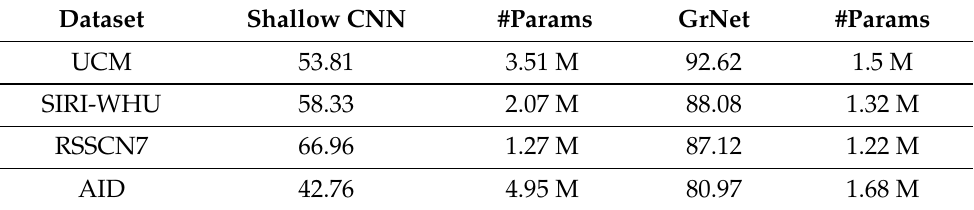
Table 5. Comparison experiments with shallow CNNs on the four datasets.